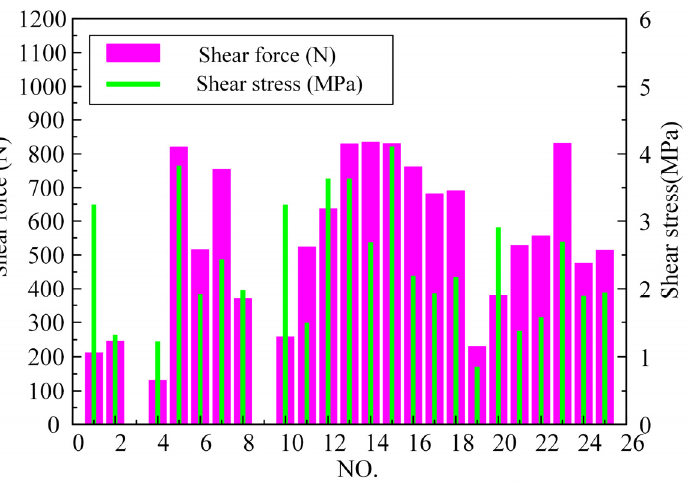
Figure 13. Orthogonal experimental design result of the 25 conditions: measured shear force and calculated tensile shear stress.